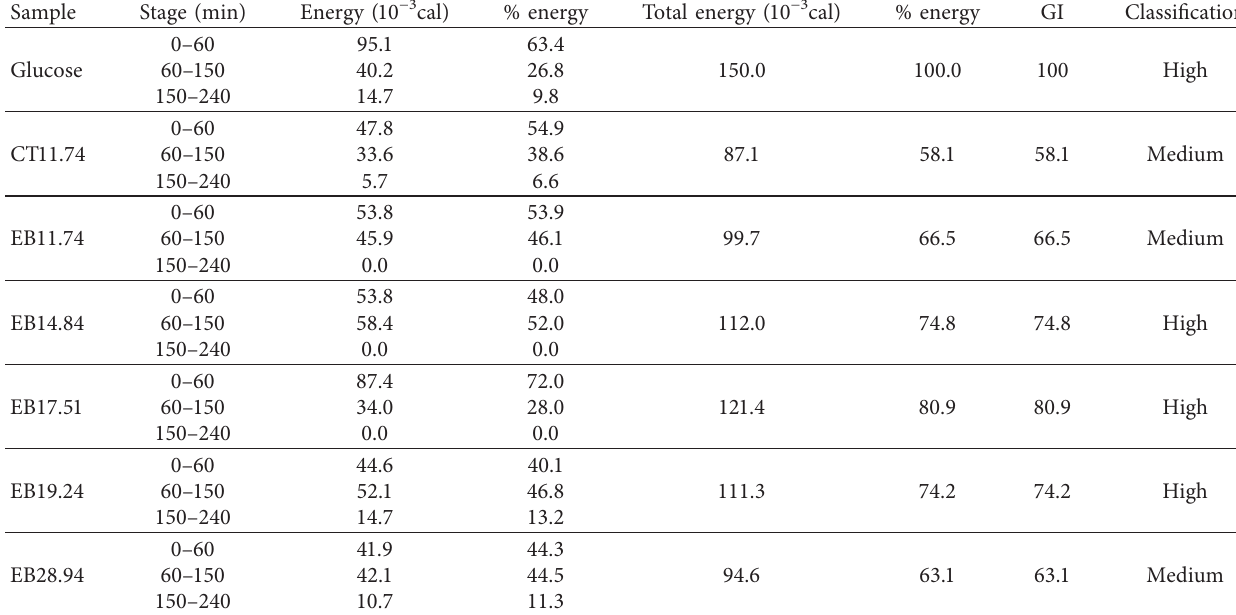
Table 3: Energy and glycemic index of in vivo digestive